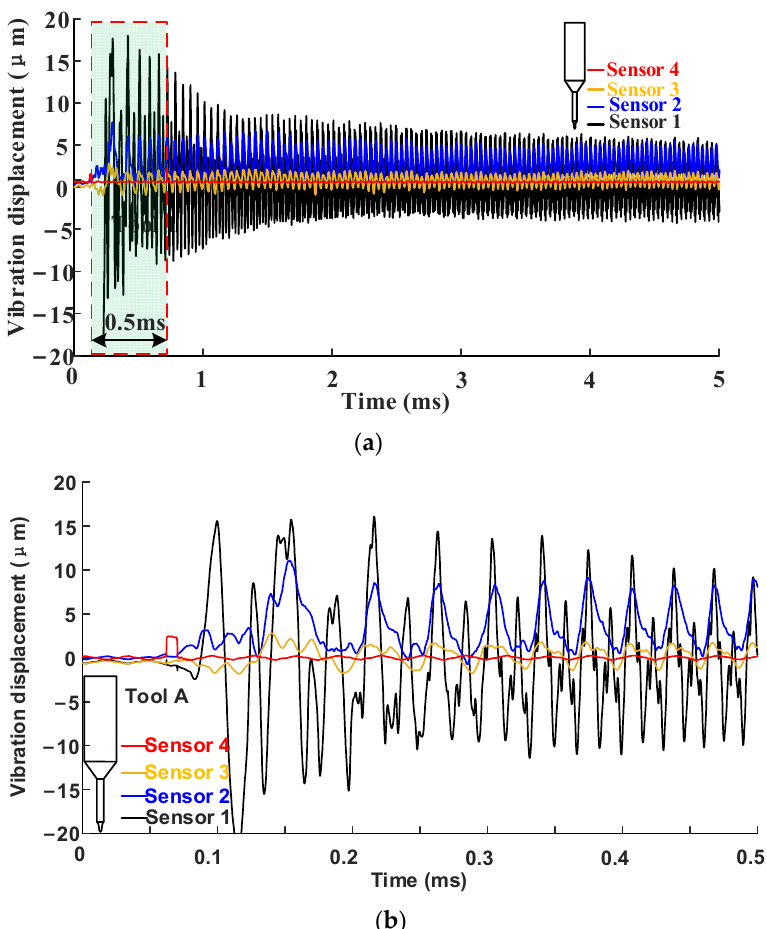
Figure 12. Impact response of Tool A at different positions. ( a ) Impact response of Tool A (raw data), ( b ) De-noised data (for clearer expression, only the first 0.5 ms is given here).